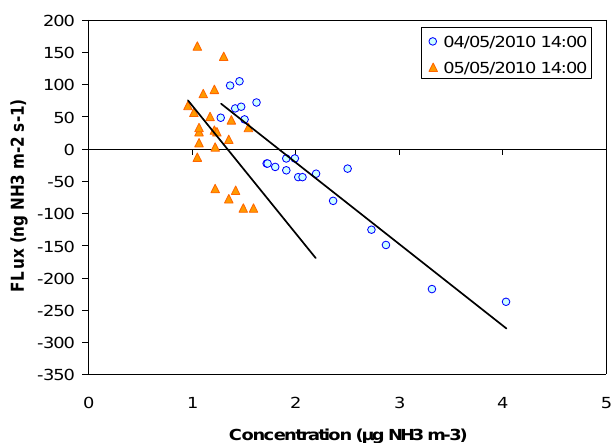
Fig. 3. Illustration of the linear regression method used to obtain Figure 3. Illustration of the linear regression method used to obtain the canopy compensation point ( C c ): C c is the intercept of the linear regression between the measured NH 3 concentration (at 1 m height) and the NH 3 flux. In this case two successive days of data are shown Cc the canopy compensation point ( C c ): C c is the intercept of the linear values of 1.8 and 1.3 µg NH 3 m -3 . regression between the measured NH3 concentration (at 1m height) and the NH3 flux. In this case two successive days of data are shown C c values of 1.8 and 1.3µgNH 3 m − 3